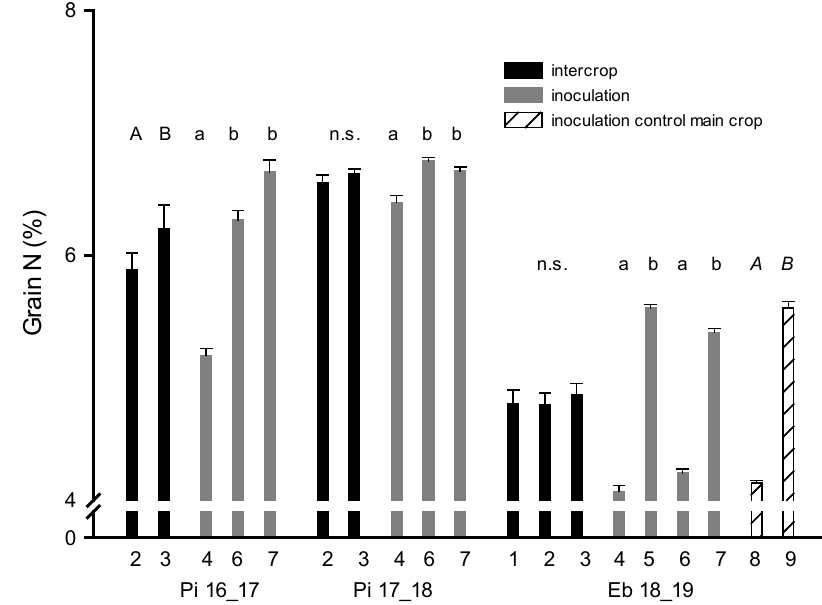
Figure 5. Grain N (%) soybean main crop. For explanations, see Figure 4. Nodule growth to the soybean main crop at one (Pi 17_18) of three sites showed that the nodule number was significantly increased by inoculation of the intercrop. In Pi 16_17, nodule number was also higher by inoculation of the intercrop compared to the uninoculated variant (u/u), but not significantly. Dual inoculation of intercrops and main crop soybean led to the highest nodules numbers and mass. At site Eb, the influence of intercrop inoculation was not visible due to poor growth of the soybean intercrop. Nevertheless, inoculation of the main soybean crop resulted in a higher number of nodules than without inoculation. The type of intercrop did not affect the nodule number of the soybean main crop (Table 5).